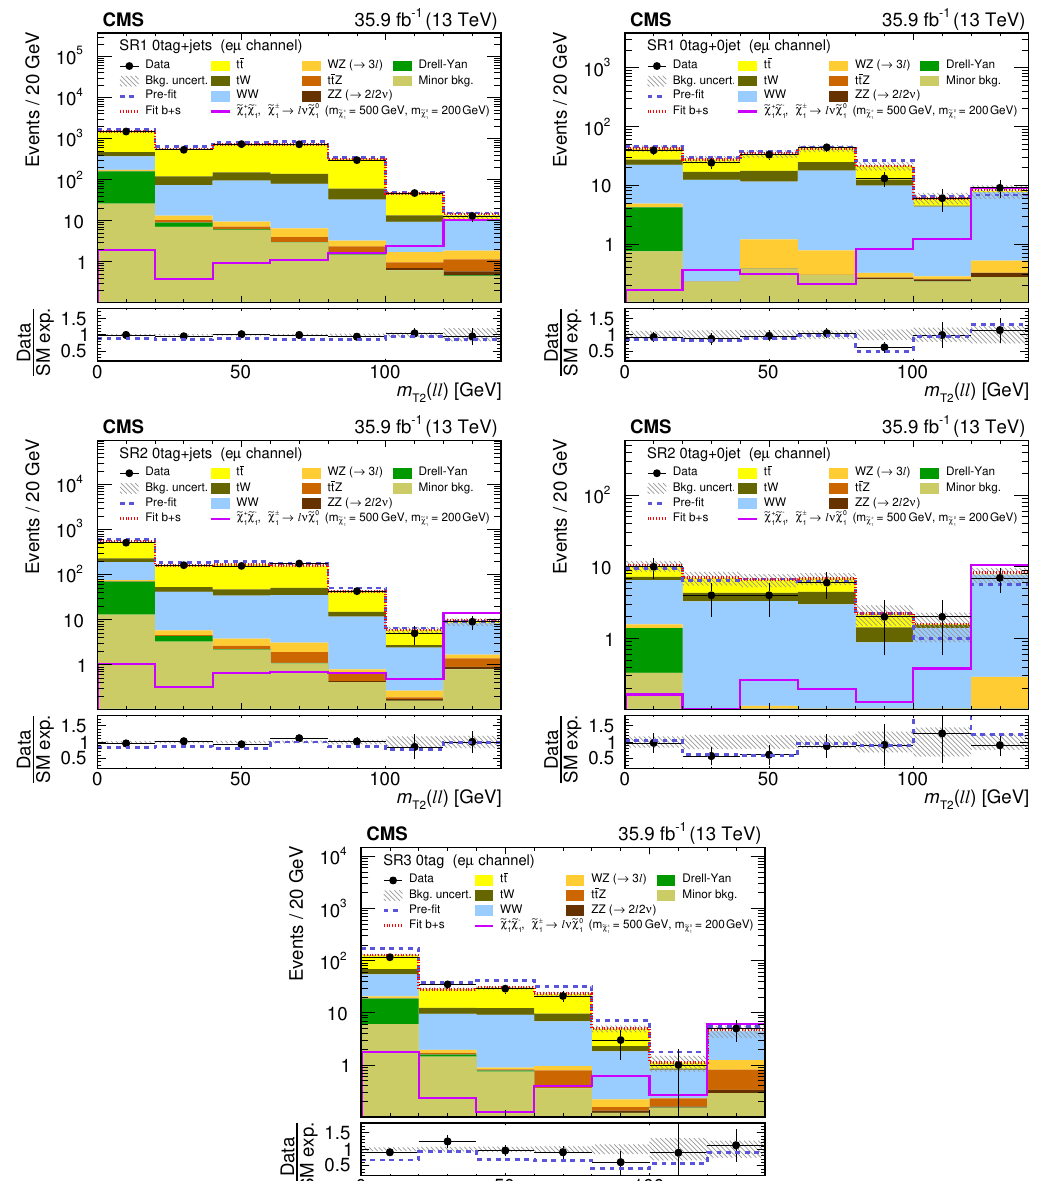
miss Figure 4 . Distributions of m < T2 ( ‘‘ ) after the (cid:12)t to data in the chargino SRs with 140 < p T 200 GeV (upper plots), 200 < p miss < 300 GeV (middle), and p miss > 300 GeV (lower), for DF T T events without b-tagged jets and at least one jet (left plots) and no jets (right plots). The lower plot for the SR with p miss > 300 GeV shows all the events without b-tagged jets regardless of their T jet multiplicity. The solid magenta histogram shows the expected m T2 ( ‘‘ ) distribution for chargino pair production with m = 500 GeV and m = 200 GeV. Expected total SM contributions before (cid:6) e (cid:31) 0 1 e (cid:31) 1 the (cid:12)t (dark blue dashed line) and after a background+signal (cid:12)t (dark red dotted line) are also shown. The last bin includes the over(cid:13)ow entries. In the bottom panel, the ratio of data and SM expectations is shown for the expected total SM contribution after the (cid:12)t using the background-only hypothesis (black dots) and before any (cid:12)t (dark blue dashed line). The hatched band represents the total uncertainty after the (cid:12)t.